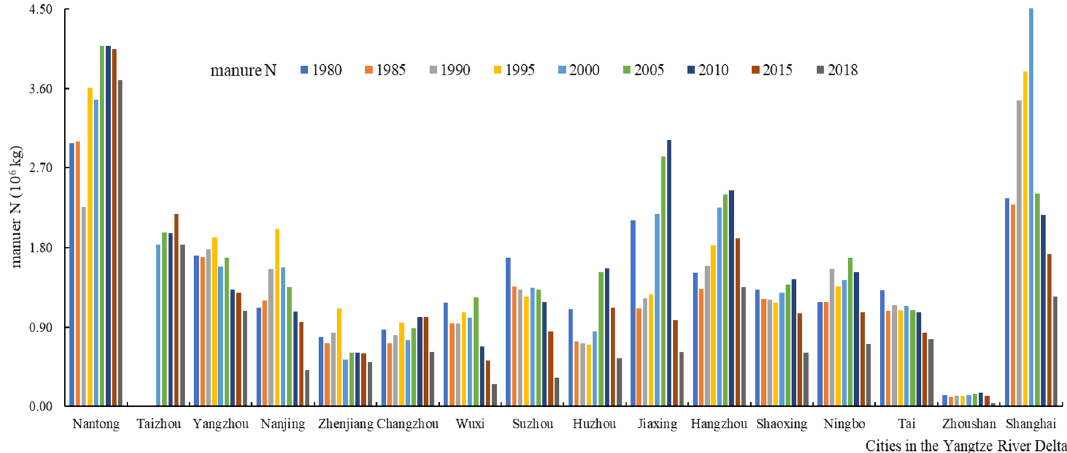
Figure 2. Manure N emissions in cities in the Yangtze River